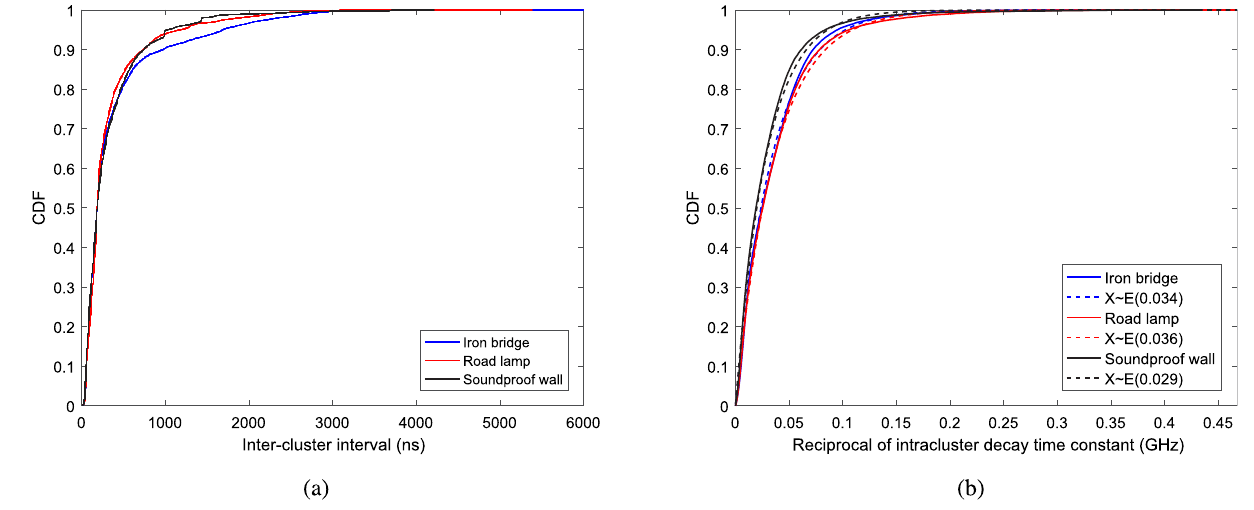
Figure 7. Statistical results of the inter-cluster interval and the intracluster decay constant. ( a ) Inter-cluster interval. ( b ) Reciprocal of intracluster decay time